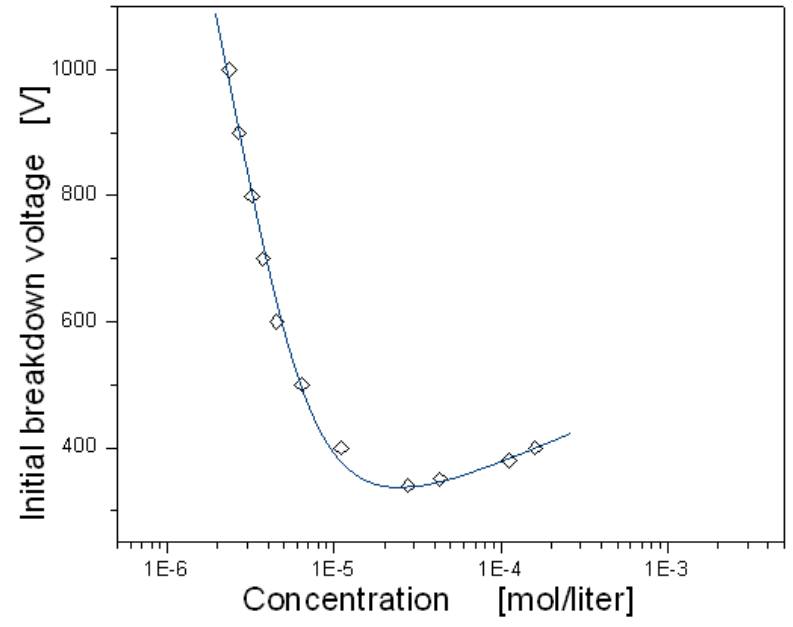
Figure 7. Dependence of initial breakdown voltage on air concentration.